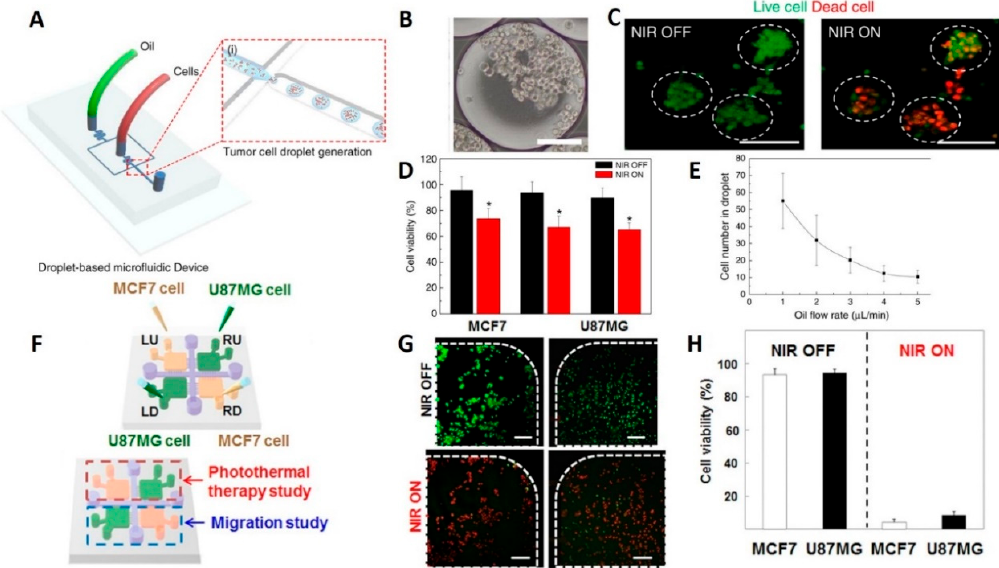
Figure 2. Glioma-on-chip platforms for photothermal therapy. ( A ) Schematic illustration of the generation of the 3D tumor spheroids. ( B ) Microscope image of the encapsulated cell in the generated droplets (scale bars are 100 µ m). ( C ) Fluorescence microscopy images showing the effects of NIR laser treatment on brain tumor spheroids. Live cells were stained with calcein AM (green) while dead cells were stained with ethidium homodimer (red) (scale bars are 100 µ m). ( D ) Results of NIR laser irradiation on the cell viability of U87MG brain tumors after being treated with rGO-BPEI-PEG nanocomposites (red bars) and control experiments without the addition of rGO-BPEI-PEG nanocomposites (black bars). ( E ) Correlation of oil flow rate in the junction to the concentration of encapsulated cells in a single droplet [35]. Reproduced with permission from [35]. ( F ) Schematic view of hydrogel microfluidic co-culture device. ( G ) Photothermal therapy of cancer cells. Fluorescent images of cell viability in square-shaped microchambers (green dots represents live and red dots are dead cells) (scale bars are 100 μ m) ( H ) Quantitative results of the viability of U87MG and MCF7 cancer cells using CCK-8 assay [36]. Reproduced with permission from [36].